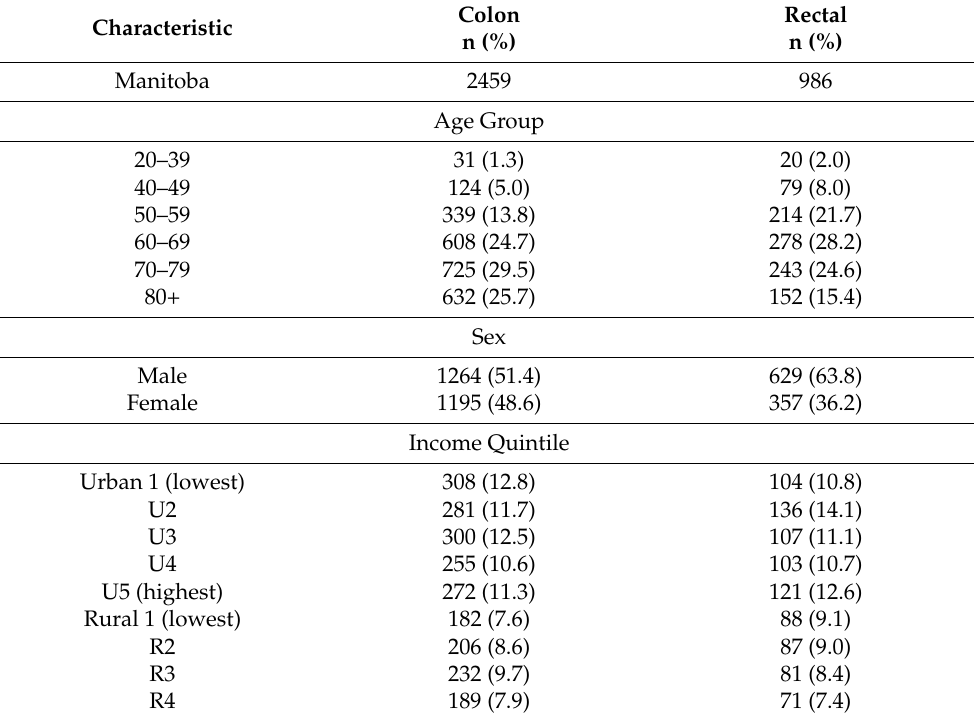
Table 1. Characteristics of individuals diagnosed with colon or rectal cancer, Manitoba, 2010–2014.